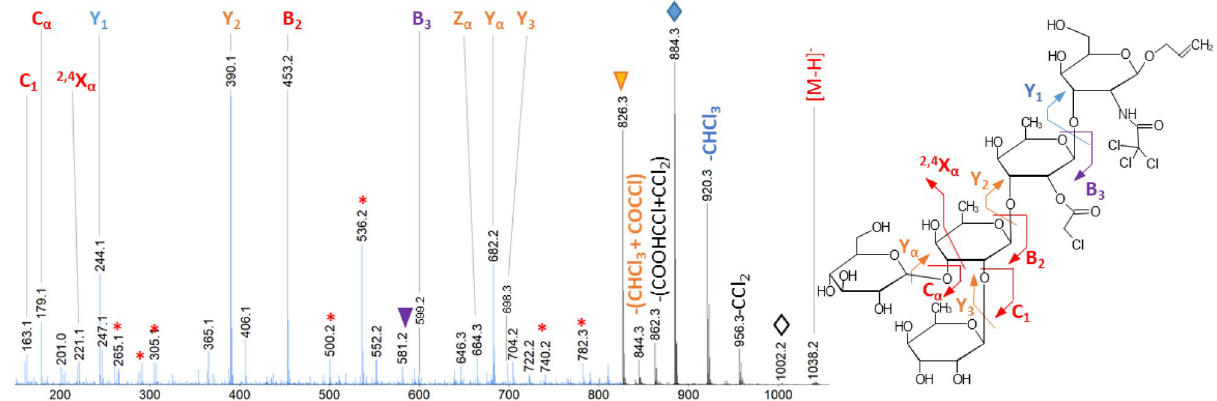
Figure 6. UHPLC-ESI–MS/MS spectrum of the pentasacharide M40-4 isolated as [M-H] − at m/z 1038.21 at t R = 22.86 min in samples from M40 validated as being substituted at OH-3 B ( P3’ ). The blue area of the spectrum is enlarged by a factor of 4 in the intensity axis. Annotations in red correspond to intact product ions. Annotation in blue correspond to product ions with a loss of CHCl 3 . Annotations in purple correspond to product ions with a loss of COCHCl. Annotation in orange correspond to product ions with a loss of CHCl 3 + COHCl 3 . All these labile function losses are in agreement with the structure. Red * indicate consecutive fragmentations, ▽ indicate H